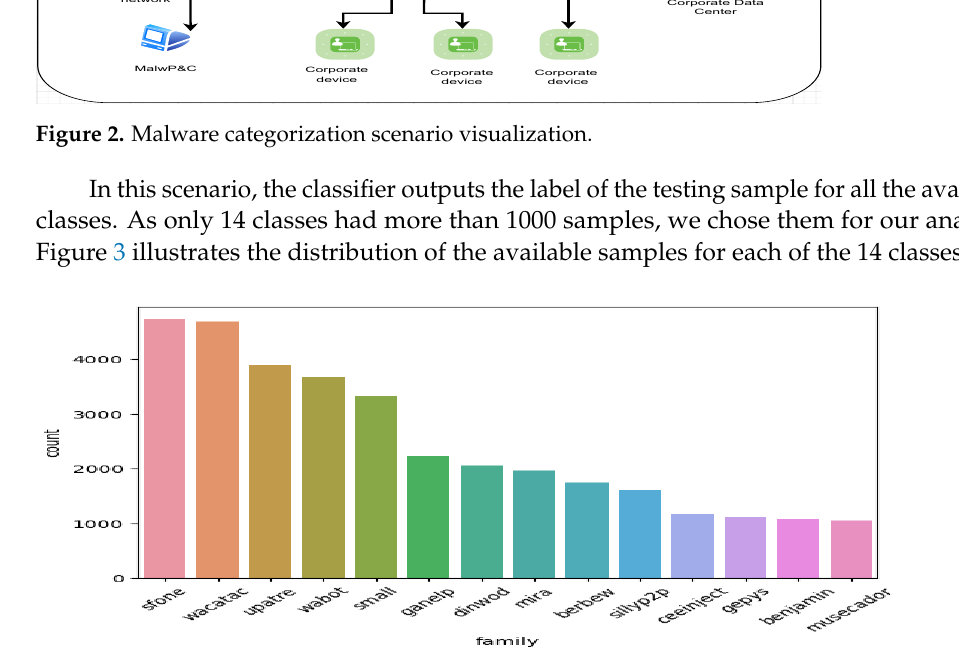
Figure 3. Distribution of the available samples per